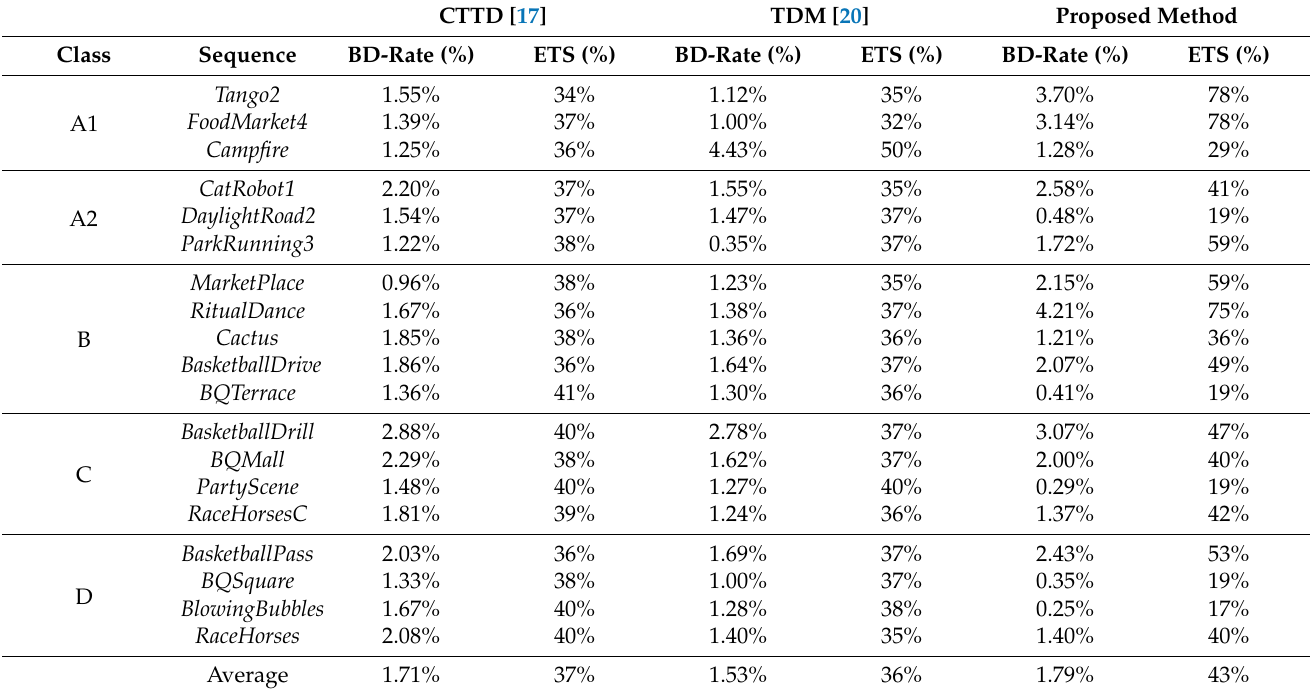
Table 5. The comparison of state-of-the-art works and the proposed method on VTM